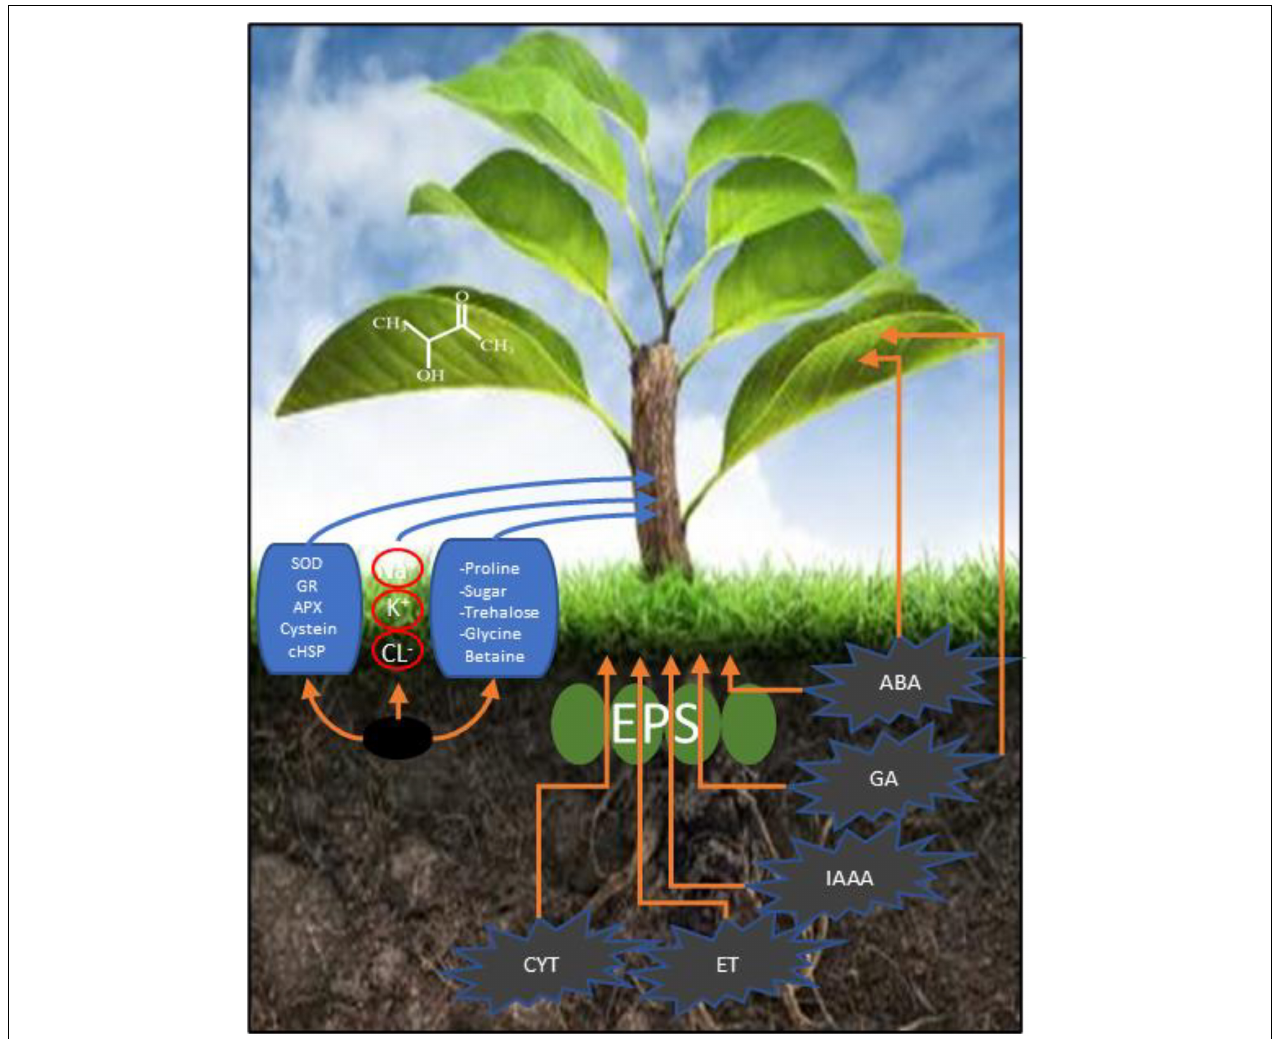
FIGURE 1 | Mechanism of action of microbial mitigation of drought stress.